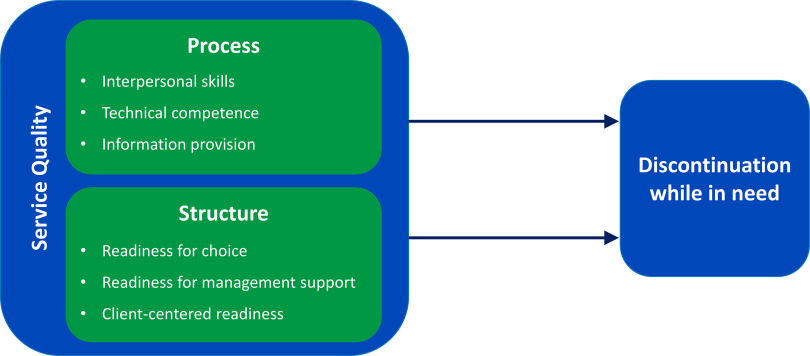
Adapted Facility-Level Quality of Care Framework